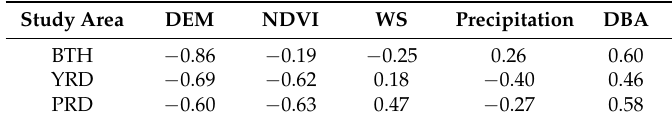
Table 3. Correlation analysis between AOD and its potential impact factors.